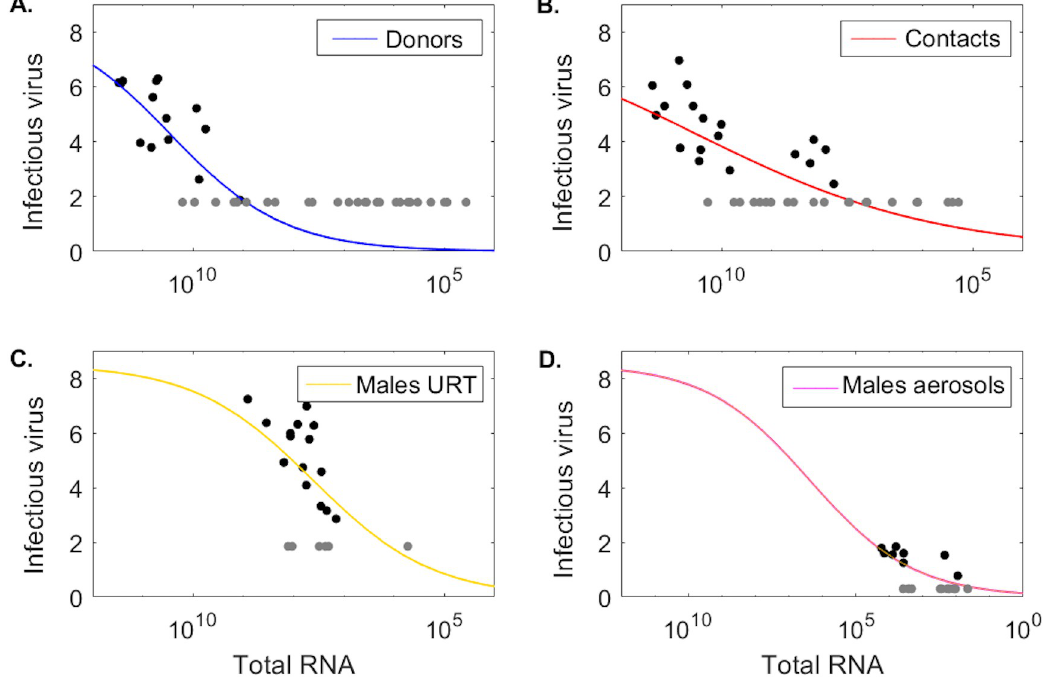
Fig 5. Infectious virus as a function of total RNA. Log10 infectious virus ν ( R versus data (circles) in (A.) donors, (B.) contacts, (C.) males URT, and (D.) males aerosols. Parameters are given in Table 3.